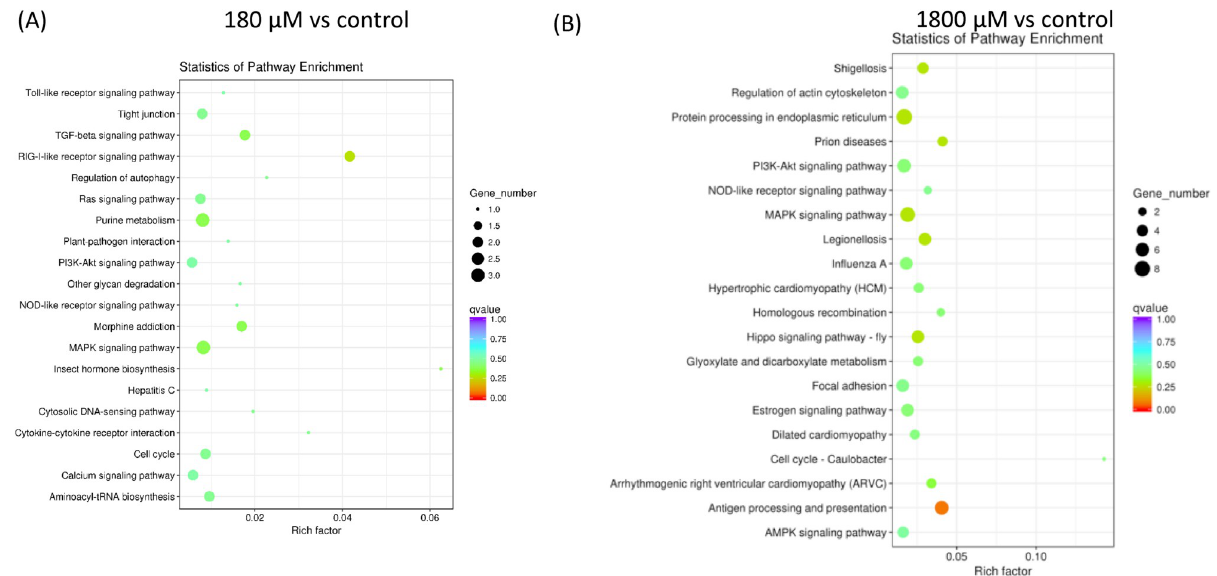
Fig 4. Scatter diagram of top 20 pathway enrichments for DEGs. The X axis corresponds to the Rich factor that is the ratio of DEGs to all the genes in this pathway. The Y axis represents the different pathway. (A) 180 μ M vs control. (B) 1800 μ M vs